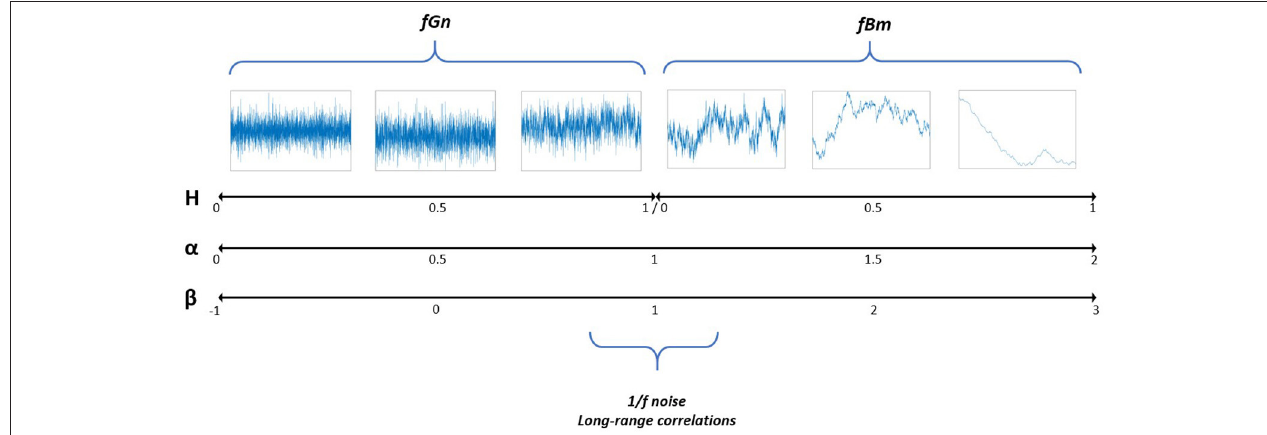
FIGURE 2 | Illustration of the fGn/fBm continuum, with corresponding Hurst exponent H, scaling exponent α and β index. This illustration was largely inspired by Marmelat (Marmelat et al.,